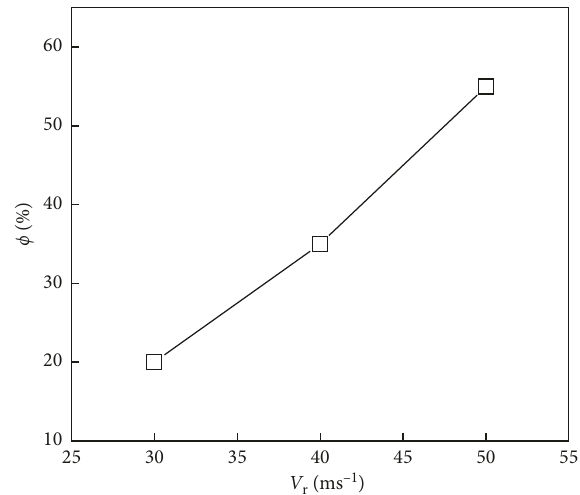
Figure 7: Relationship between the hollow ratio of Ni-5% Pb alloys with low Pb content and the roller